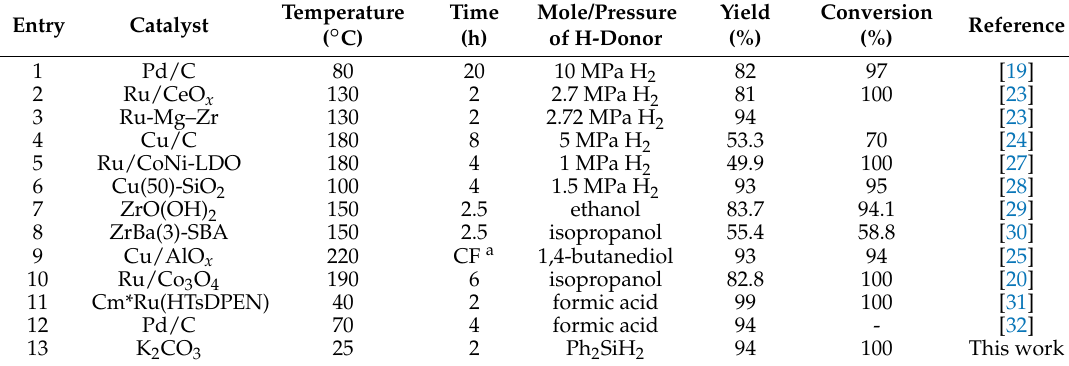
a CF: Continuous flow.